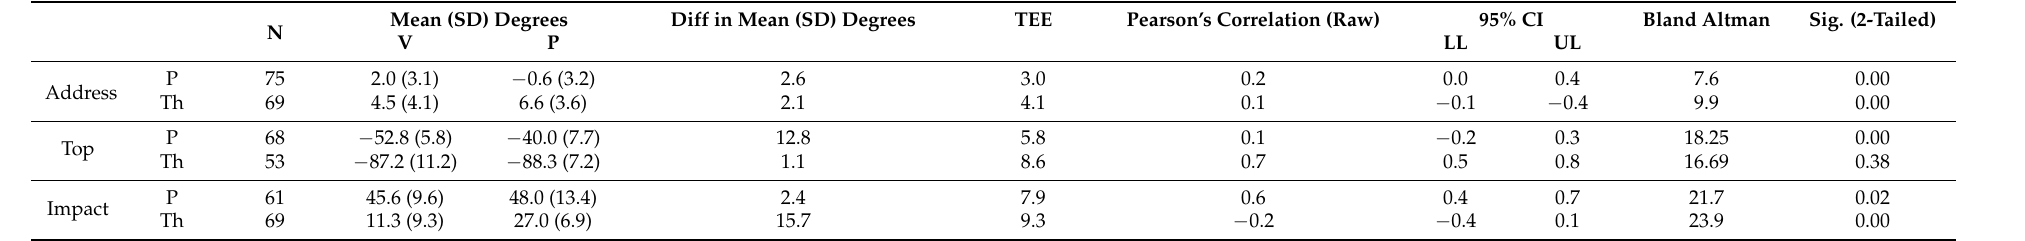
Table 7. Comparison between Polhemus Liberty (practical) and VICON Nexus (criterion) in the longitudinal